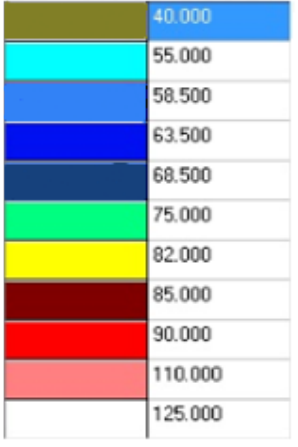
Figure 14. Distribution of colors on the model.